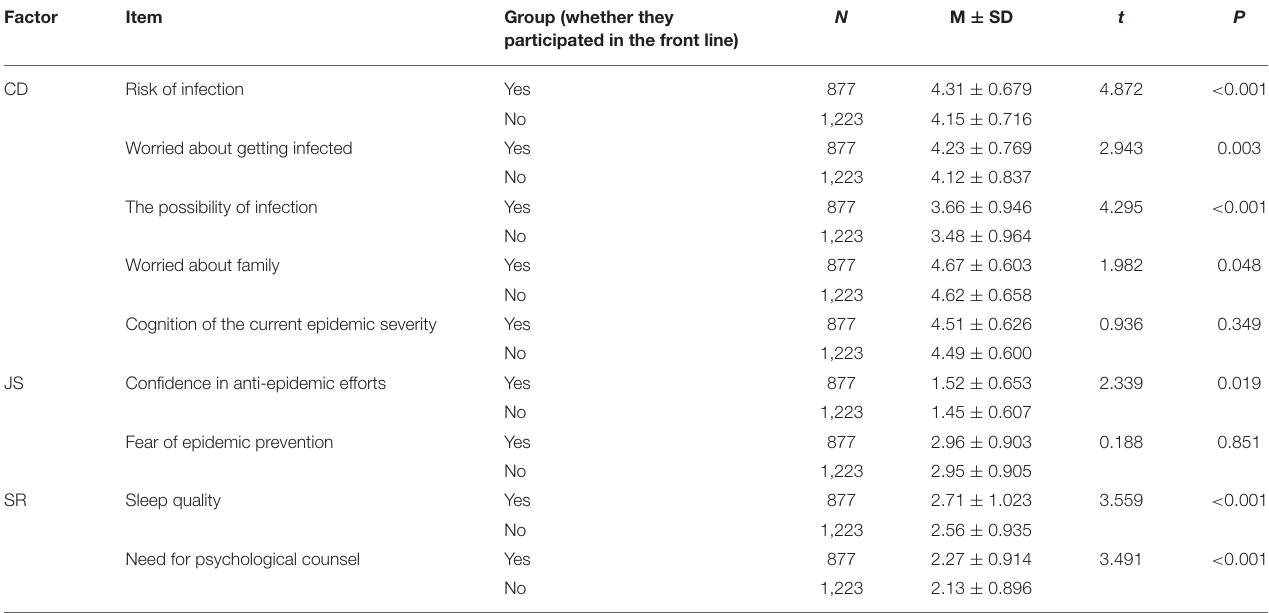
TABLE 4 | Differences in participation in first-line rescue. Factor